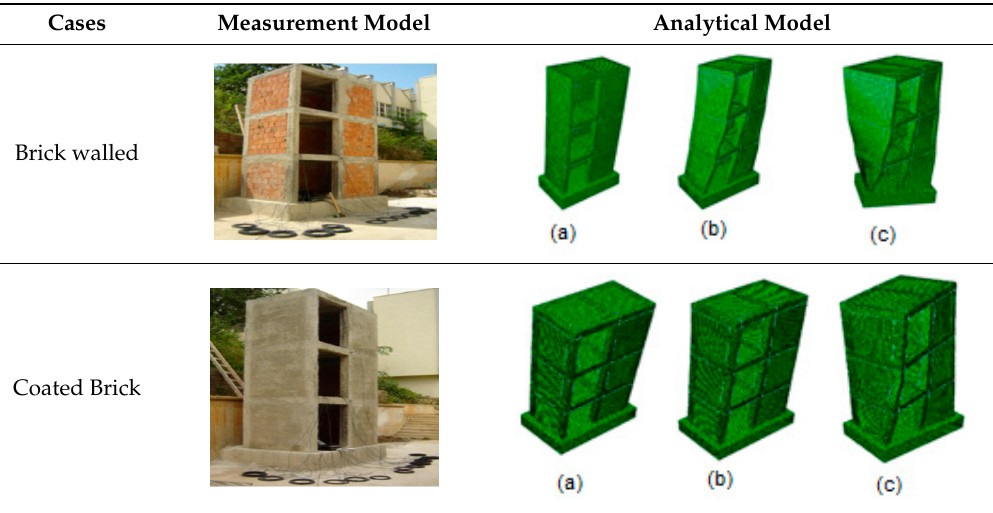
Table 5. First five mode shapes identified analytically of the brick walled and coated-wall case: (a) 1st Transverse mode, (b) 2nd Longitudinal mode, (c) 3rd Torsional mode, respectively.